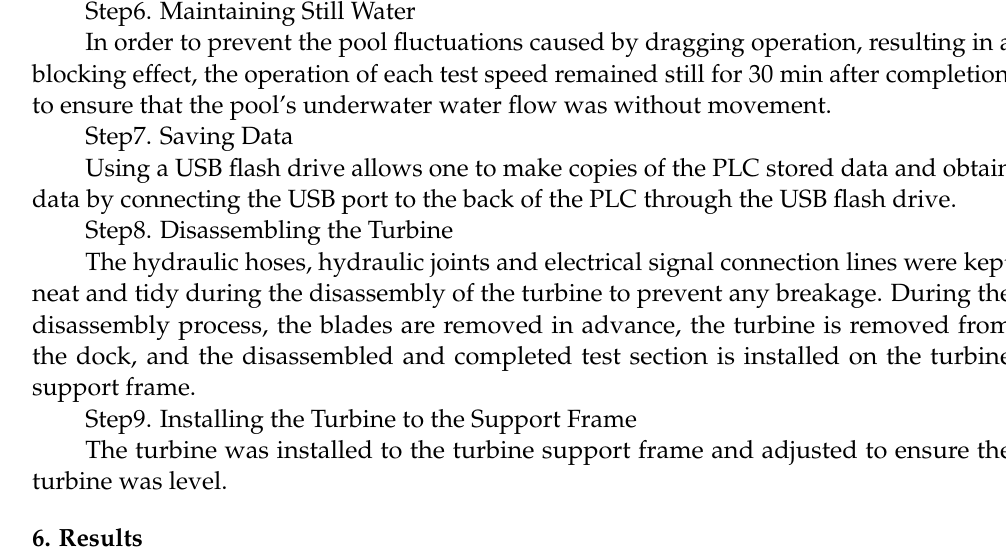
Figure 12. Towing test under different working conditions. ( a ) 0.1 m/s working condition; ( b ) 0.3 m/s working condition, ( c ) 0.5 m/s working condition.